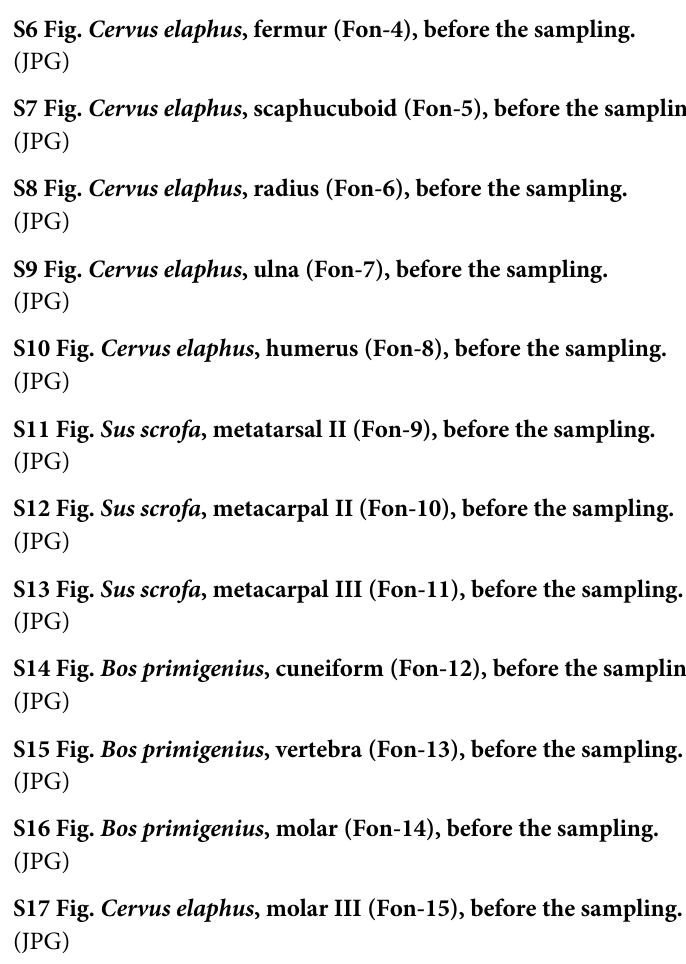
S15 Fig. Bos primigenius , vertebra (Fon-13), before the sampling. S16 Fig. Bos primigenius , molar (Fon-14), before the sampling. (JPG) S17 Fig. Cervus elaphus , molar III (Fon-15), before the